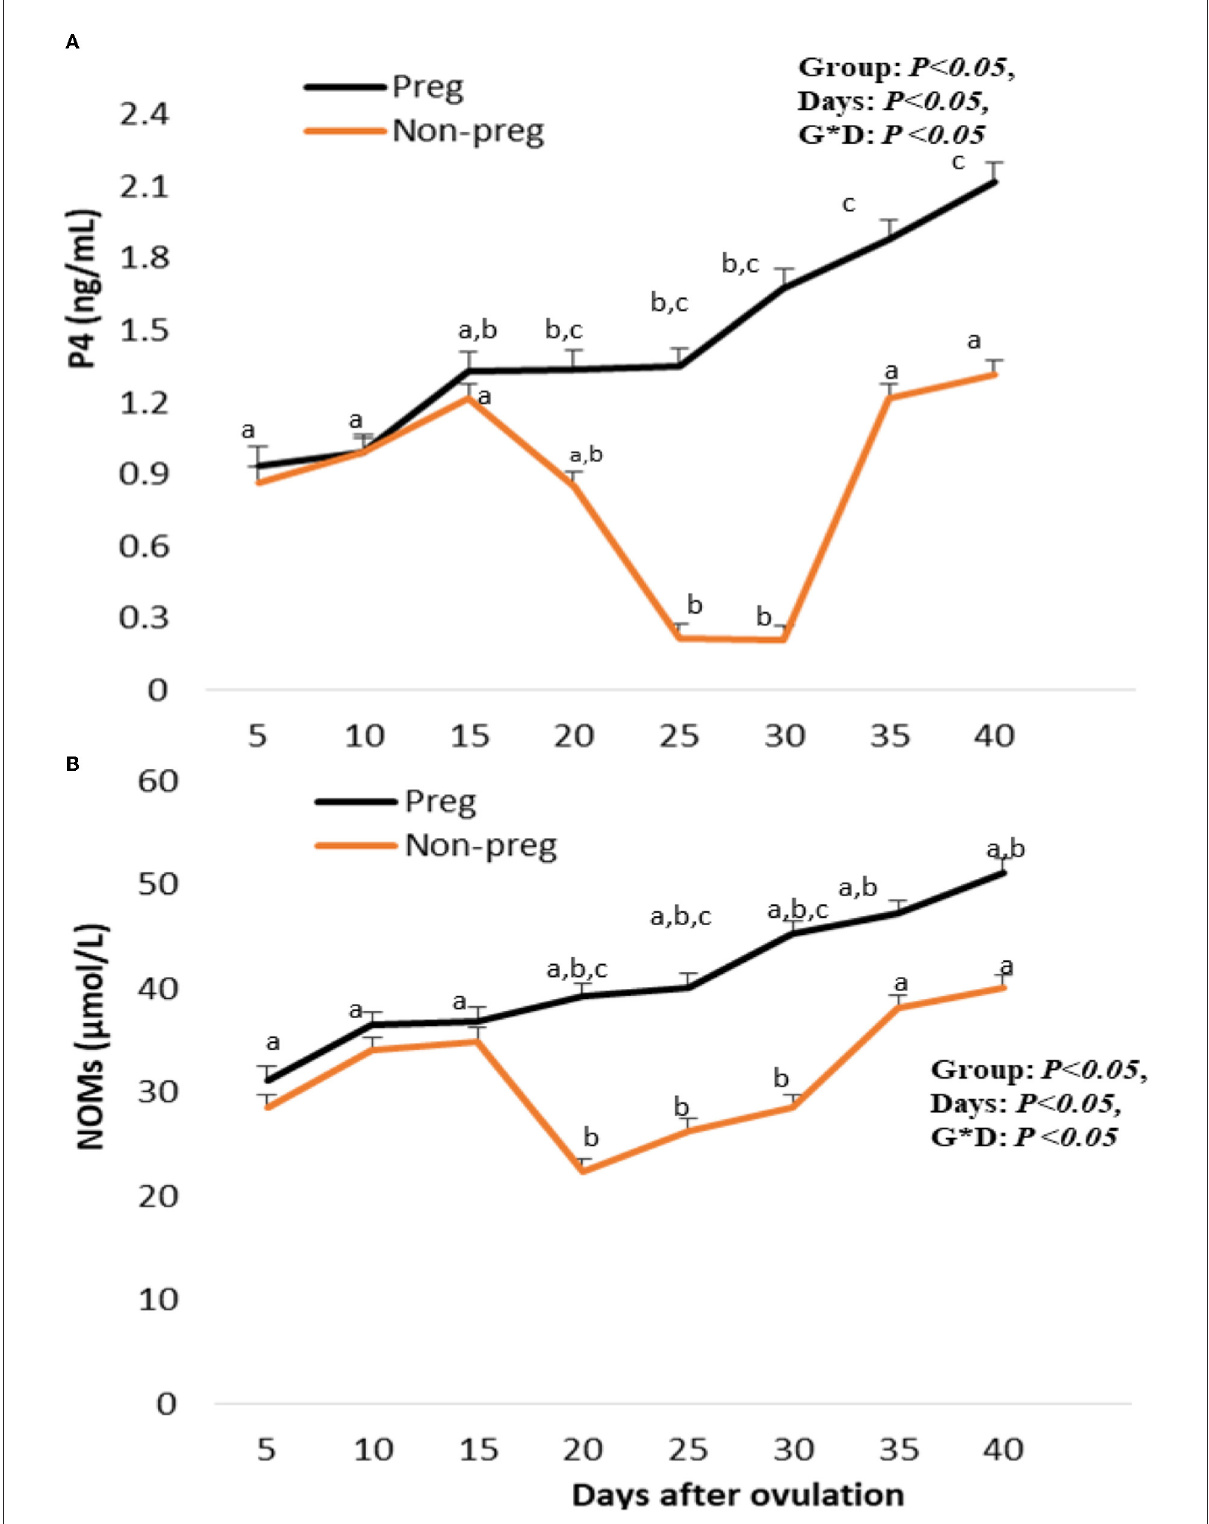
FIGURE9 Plasma progesterone (P4; ng/mL; A ), and serum nitric oxdie metabolites (NOMs; µ mol/L; B ) levels presented in pregnant (Preg) and non-pregnant (Non-preg) buffalos from day 5 till day 40 after ovulation. Data are obtained as mean with standard error of mean. a,b Values are significantly different at P < 0.05 compared with day 5 in both groups, while c value is significantly different at P < 0.05 between two groups at the indicated same time